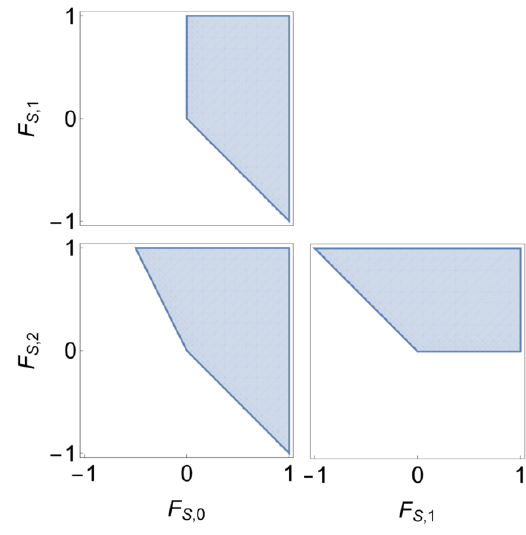
Figure 20 . Positivity constraints on all F S;i pairs.